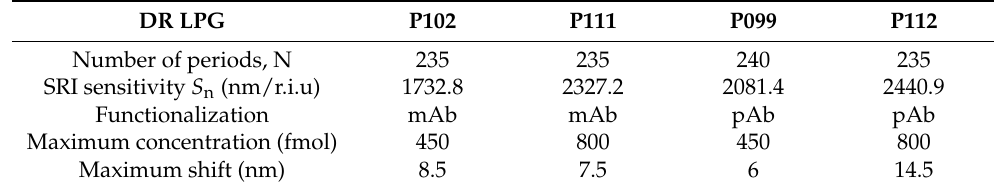
Table 1. Sensitivity S n to SRI and type of functionalization of the DR LPGs used in the experiments. DR LPG P102 P111 P099 P112 Number of periods, N 235 235 240 235 SRI sensitivity S n (nm/r.i.u) 1732.8 2327.2 2081.4 2440.9 Functionalization mAb mAb pAb pAb Maximum concentration (fmol) 450 800 450 800 Maximum shift (nm) 8.5 7.5 6